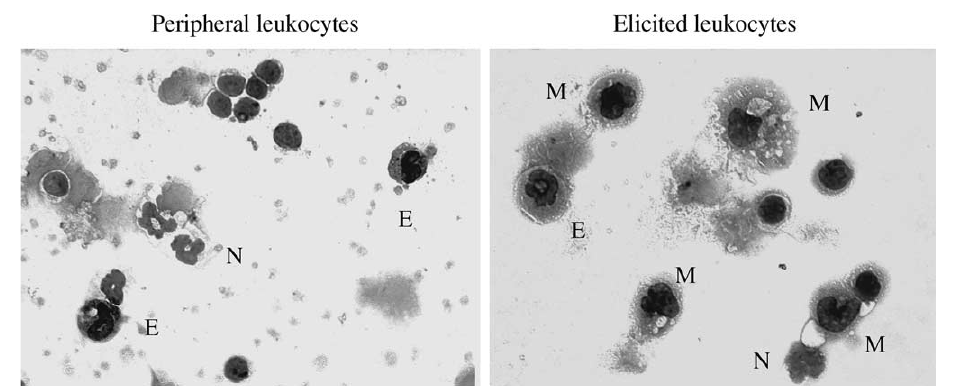
FIG. 6. Cellular source of CCL6. Cytospin preparations of peripheral leukocytes and thioglycollate-elicited leukocytes at 8 h were stained with anti-CCL6 IgG. E, eosinophils; M, macrophages; N, neutrophils. Shown are representative data from three independent preparations.